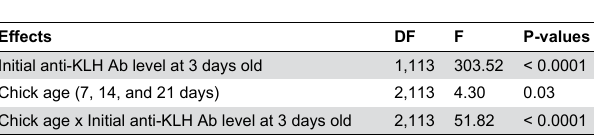
Table 2. Output of the best-fit generalized mixed model that explains variation in anti-KLH Ab levels in chicks as they age.